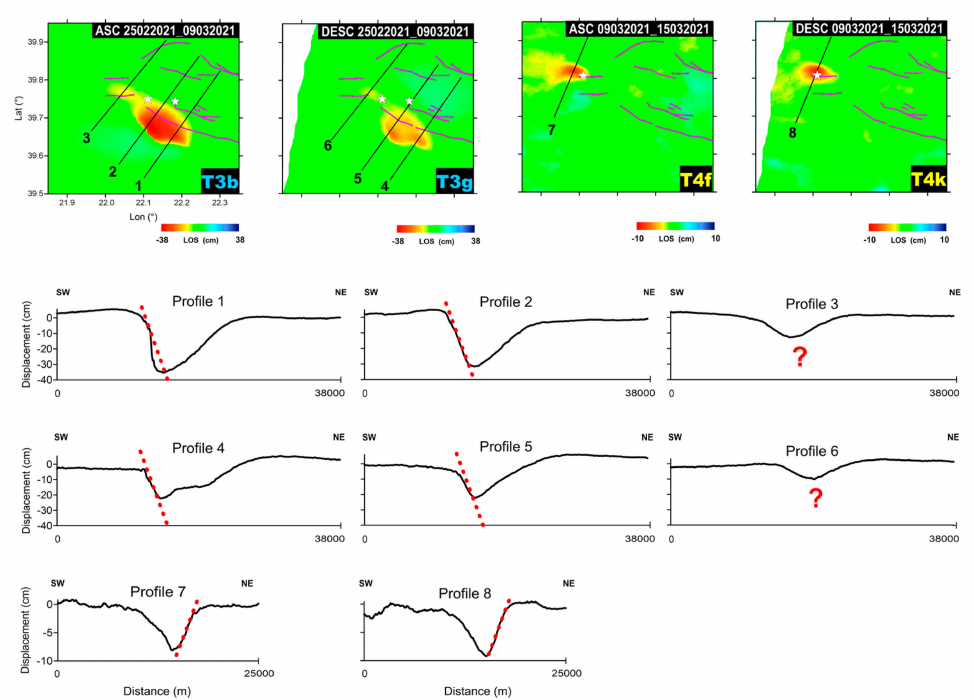
Figure 5. Displacement maps and profiles. ( Upper panels) LOS displacement maps for the indicated timeframes together with the selected profiles. ( Lower panels) Displacement profiles for Mw 6.3, 6.0, and 5.6 InSAR measurement for T3 and T4; dashed red lines indicate their dipping direction. The question marks in right panels indicate that the displacement in the corresponding profiles did not allow us to discriminate the dipping of the fault plane (Mw 6.0) (see main text for the